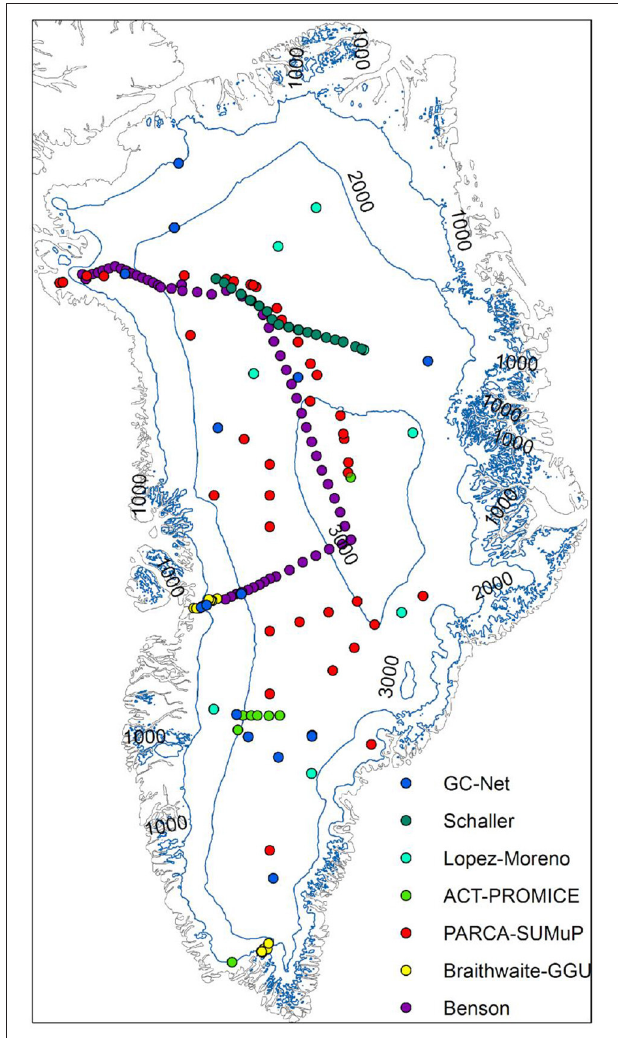
FIGURE 1 | Locations of all surface snow density measurement locations in our dataset. Contours lines indicate elevations in meters above sea